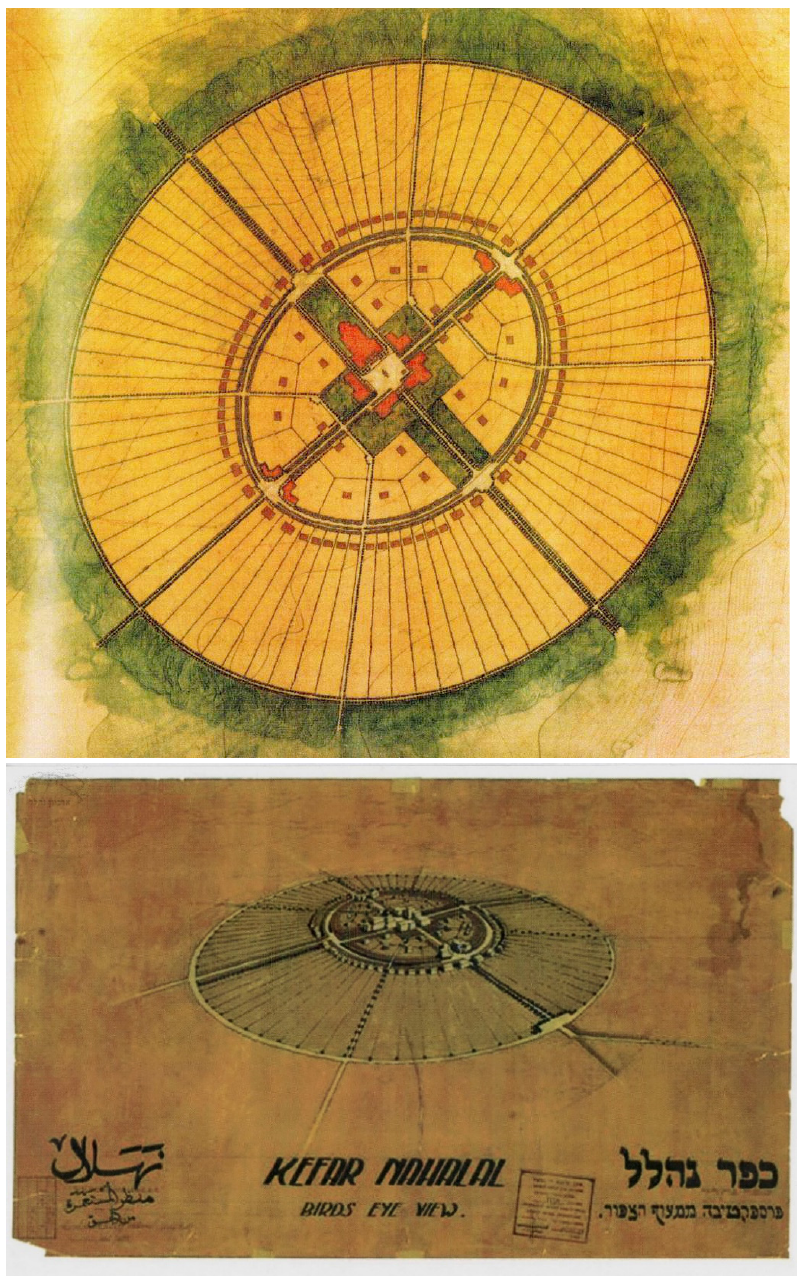
Figure 1. The Nahalal plan and diagram, planned by Richard Kaufmann (1921). The public area included around 50 acres, of which half (25 acres) were designated for public servants’ residences [9]. The size of the public area was derived from the width of the farmers’ housing units, and out of consideration for agricultural machinery, rather than for functional needs [4]. Source: Nahalal Archive.